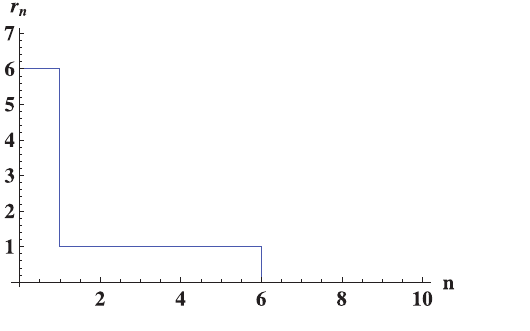
Figure 2. Fitness r n versus Hamming distance n from the peak sequence for the truncated fitness